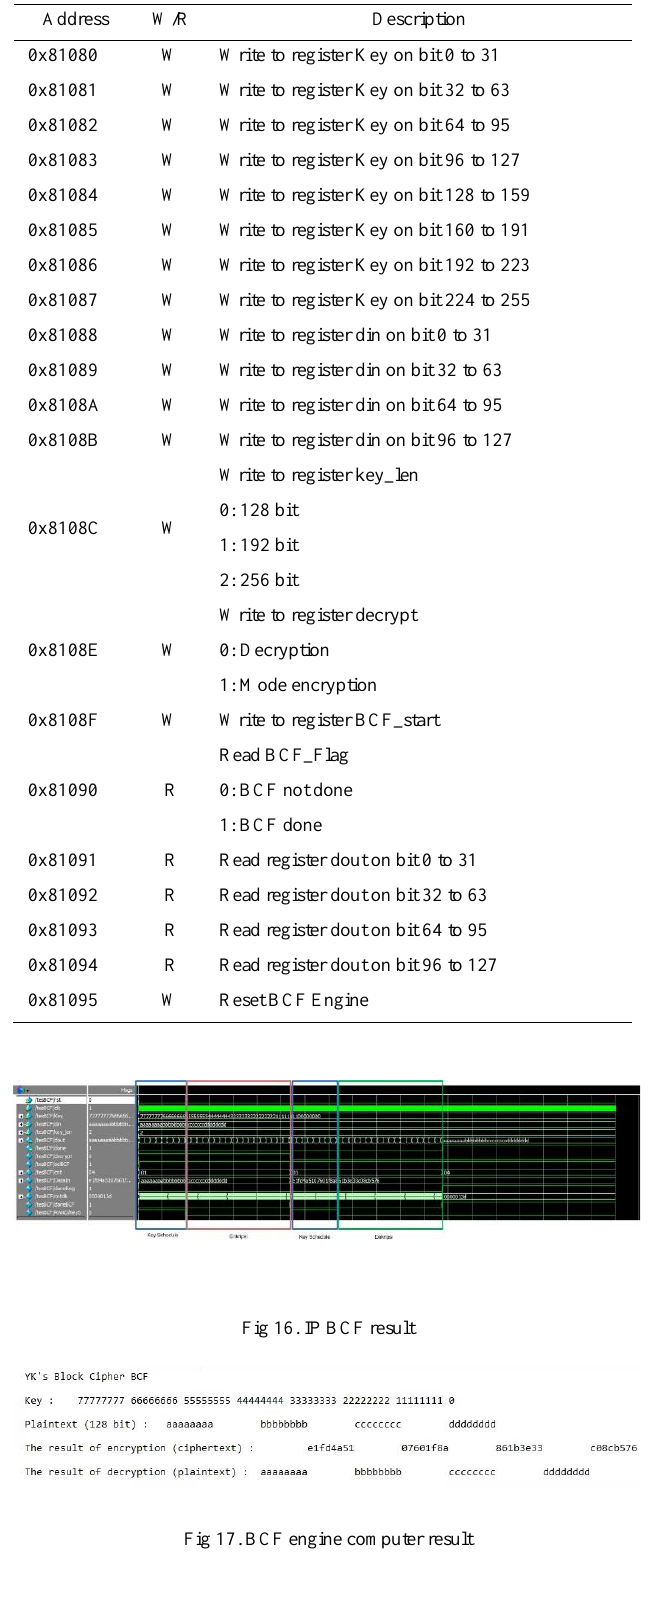
Table 11. Register for